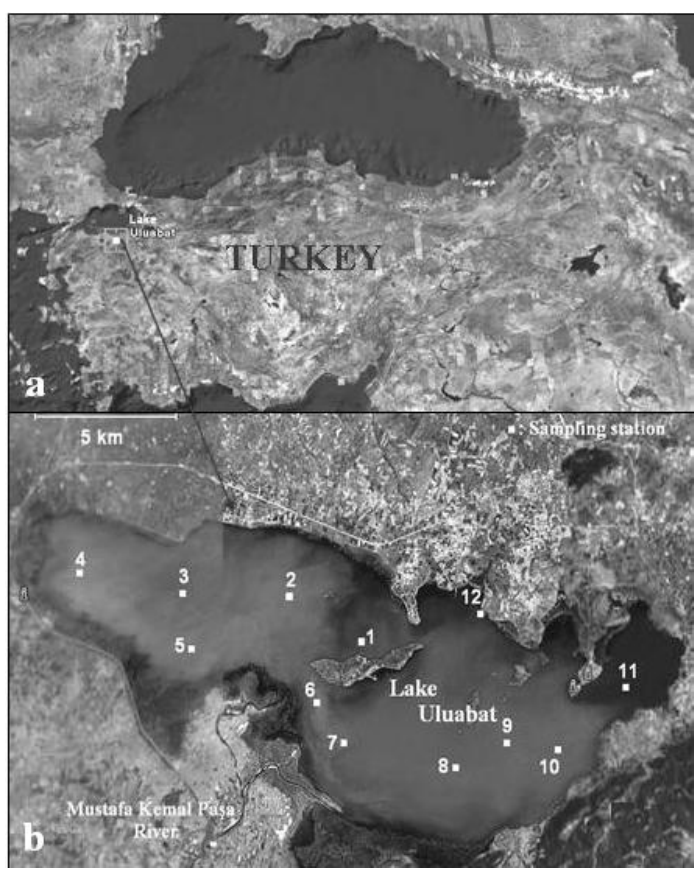
FIGURE 1. (a) Geographical situation of Lake Uluabat, Turkey; (b) sampling stations; (c) catchment area and the some emissions affecting the lake (next